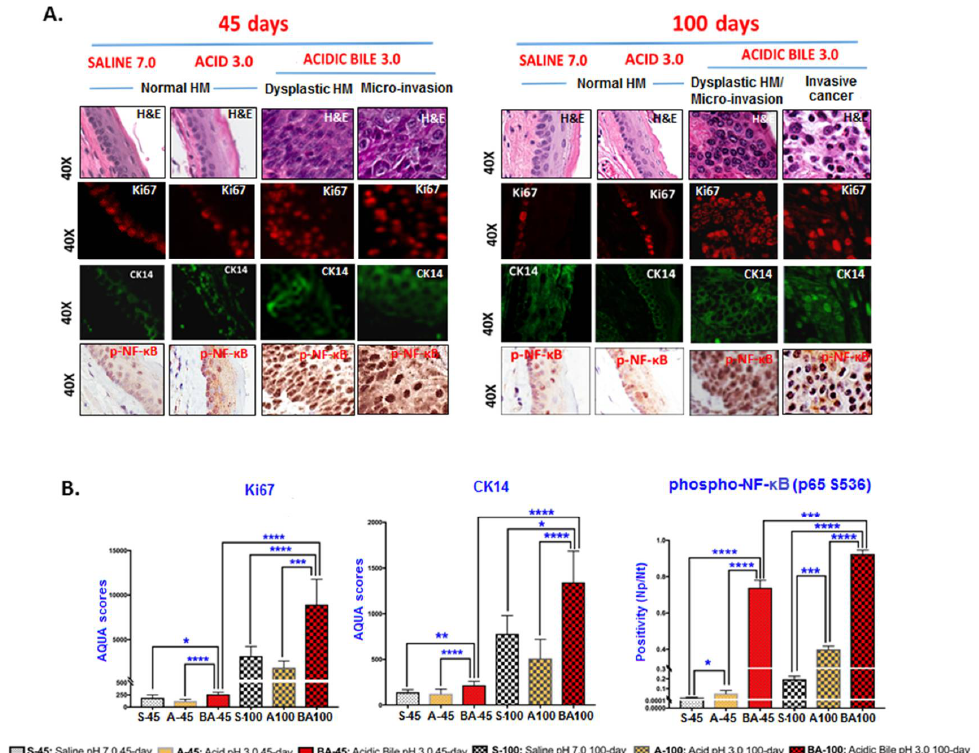
Figure 2. Underlying molecular alterations linked to histopathological changes at 45 days and 100 days of exposure. ( A ) Immunofluorescence staining was used for Ki67 (DyLight ® 549 for red) and CK14 (DyLight ® 488 for green) (DAPI was used for nuclear staining (not seen here)). IHC analysis for p-NF- κ B (p65 S536) (brown) was performed using chromogenic staining. ( B ) Graphs created by GraphPad Prism 7.0 demonstrate the statistically significant differences of mean AQUA (automated quantitative analysis) scores for Ki67 (nuclear) and CK14 (nuclear and cytoplasmic) or nuclear positivity for p-NF-κB (positivity = nuclear − positive/total number of nuclei; Image Scope software) between acidic bile vs. controls, and between acidic bile 45-day vs. acidic bile 100-day treated groups (* p < 0.01; ** p < 0.001; *** p < 0.0001; **** p < 0.00001 ; t -test; multiple comparisons using Holm–Sidak; GraphPad Prism 7.0). The BA 100 in the bar graphs represent both dysplastic HM and invasive cancer.